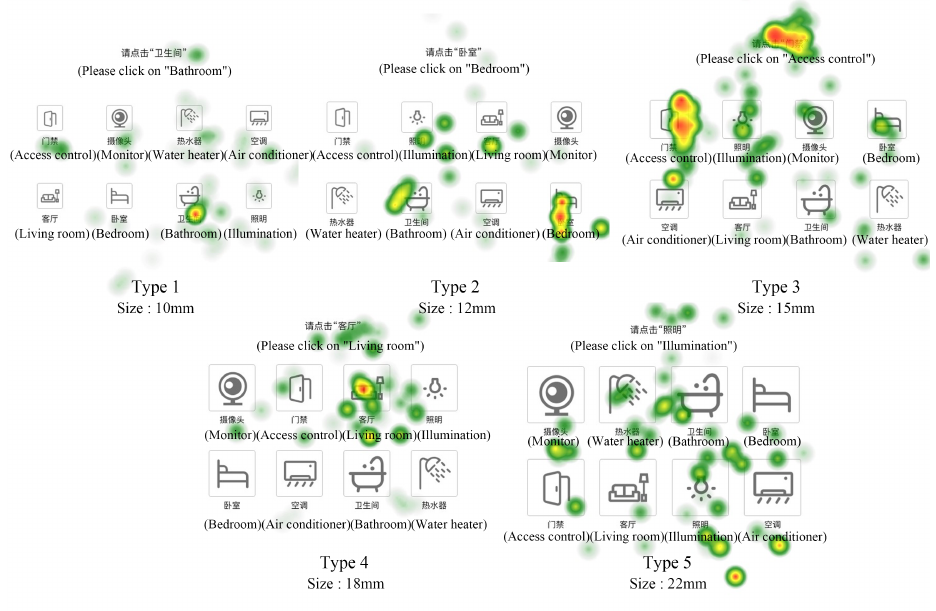
Figure 13. Eye movement heat map of different size button experiment